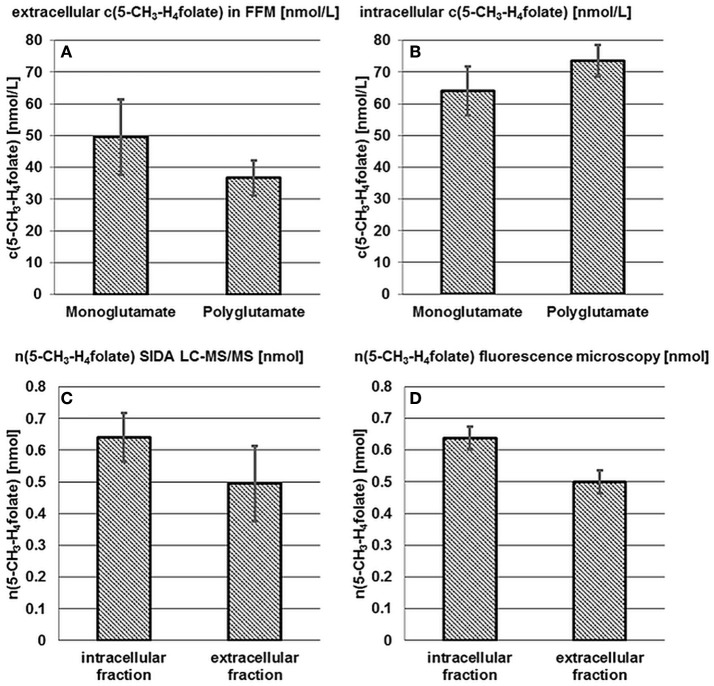
Accumulation and release of 5-CH3-H4folate by B. pseudocatenulatum DSM 20438T. See Figure 2.